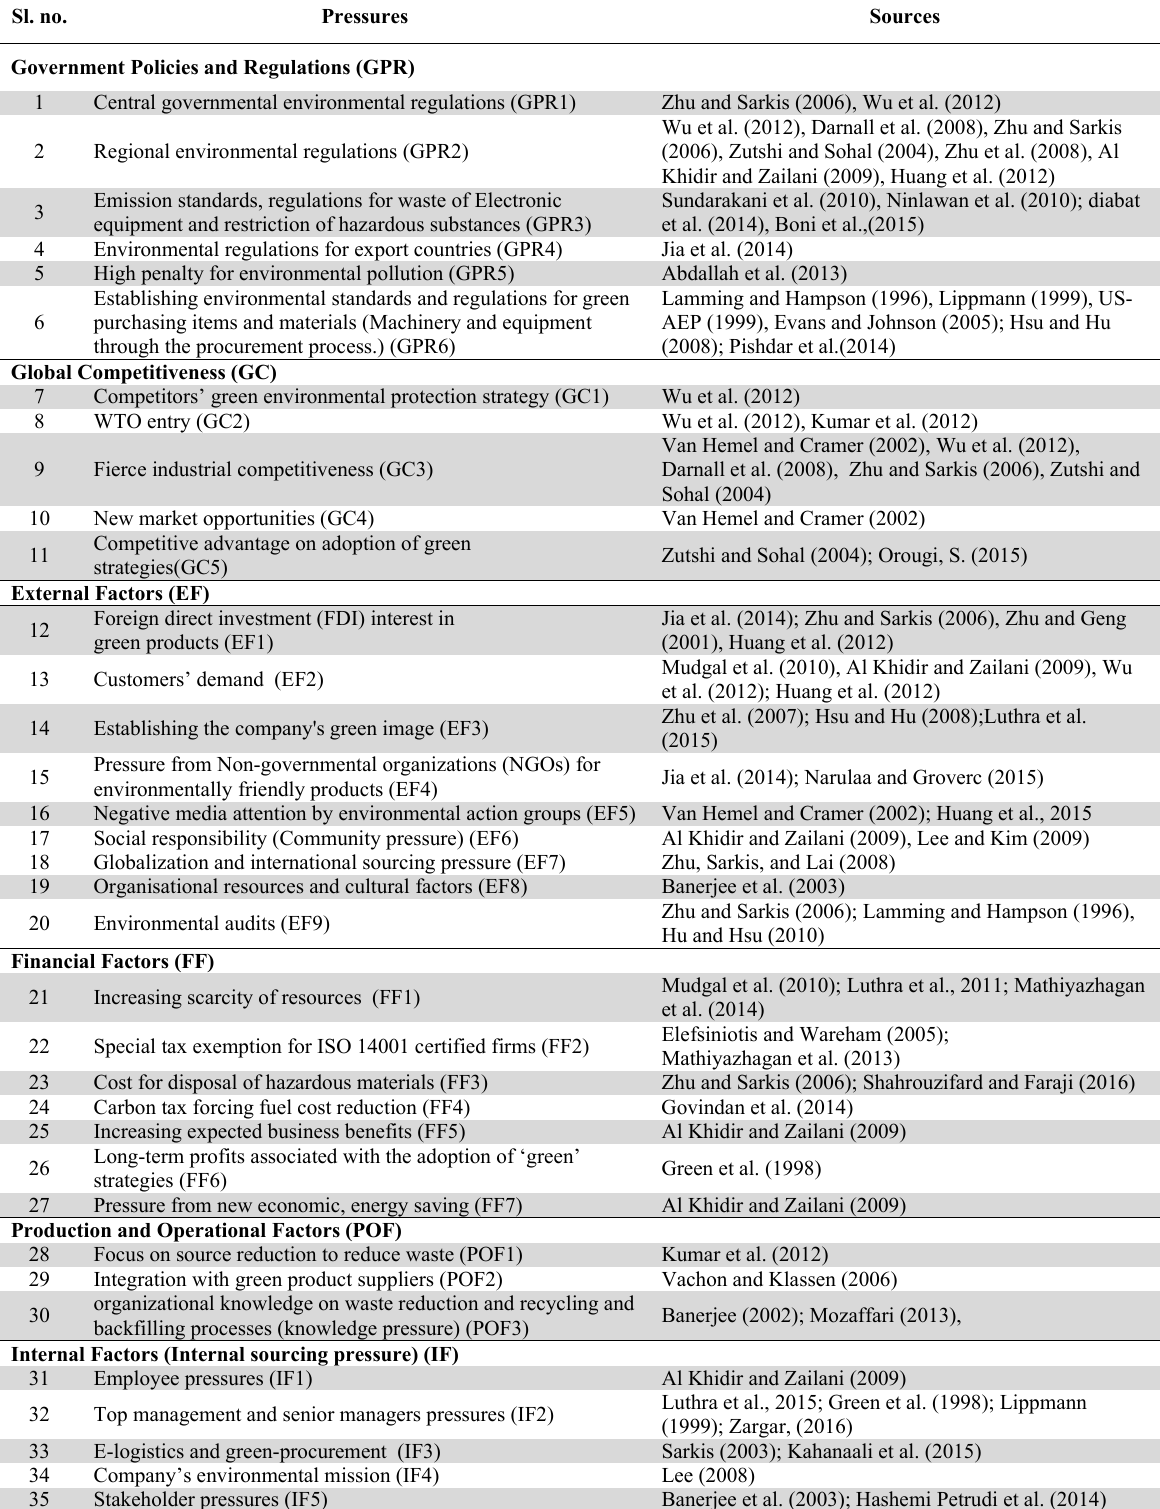
Pressures for the adoption of GSCM from literature Sl.